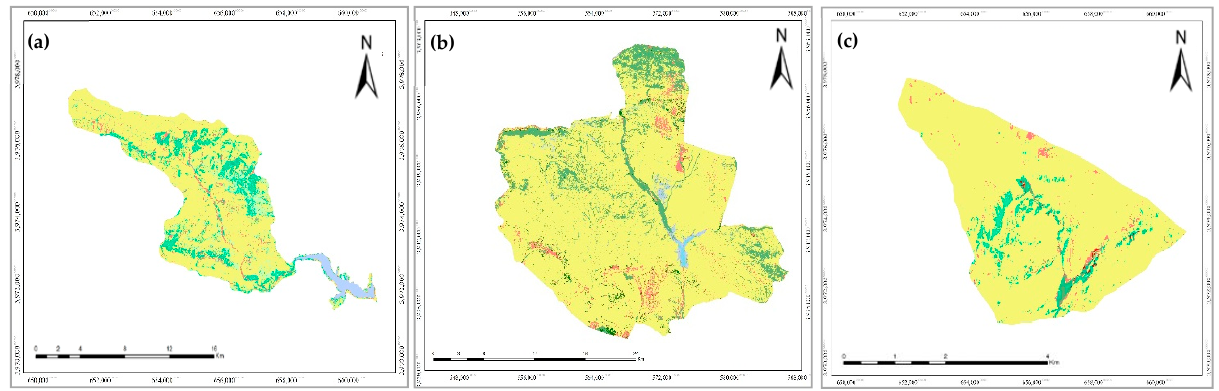
Figure 1. Location of the studied areas; ( a ) Lar, ( b ) Jajrud, and ( c )